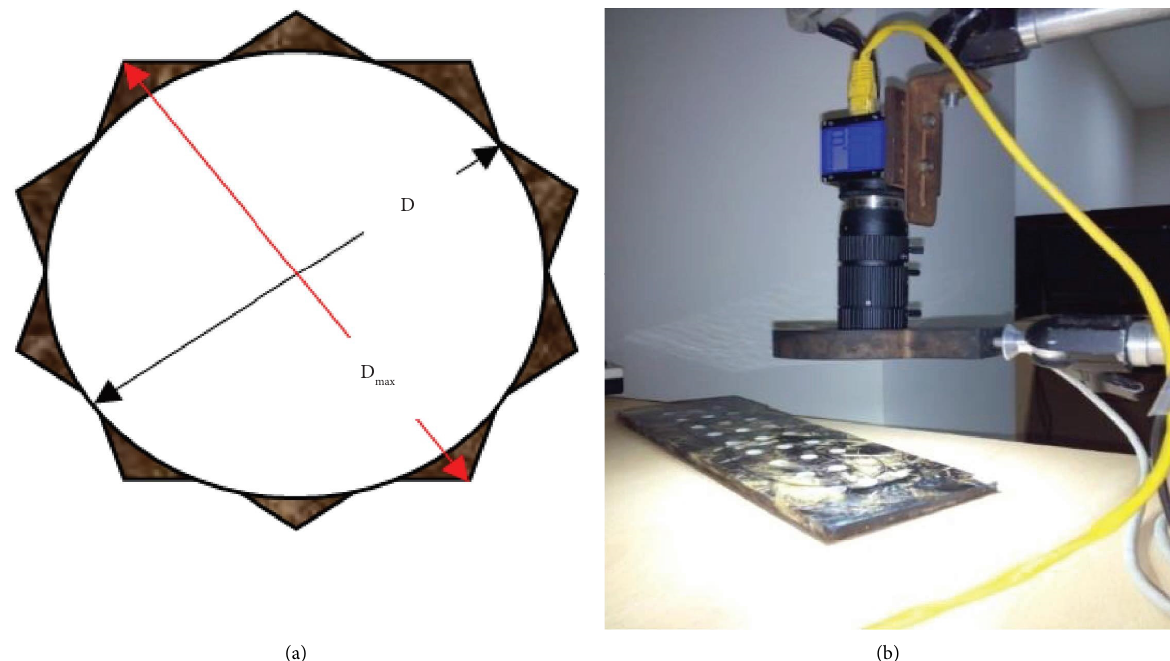
Figure 2: (a) Delamination in a drilled hole. (b) Machine vision set